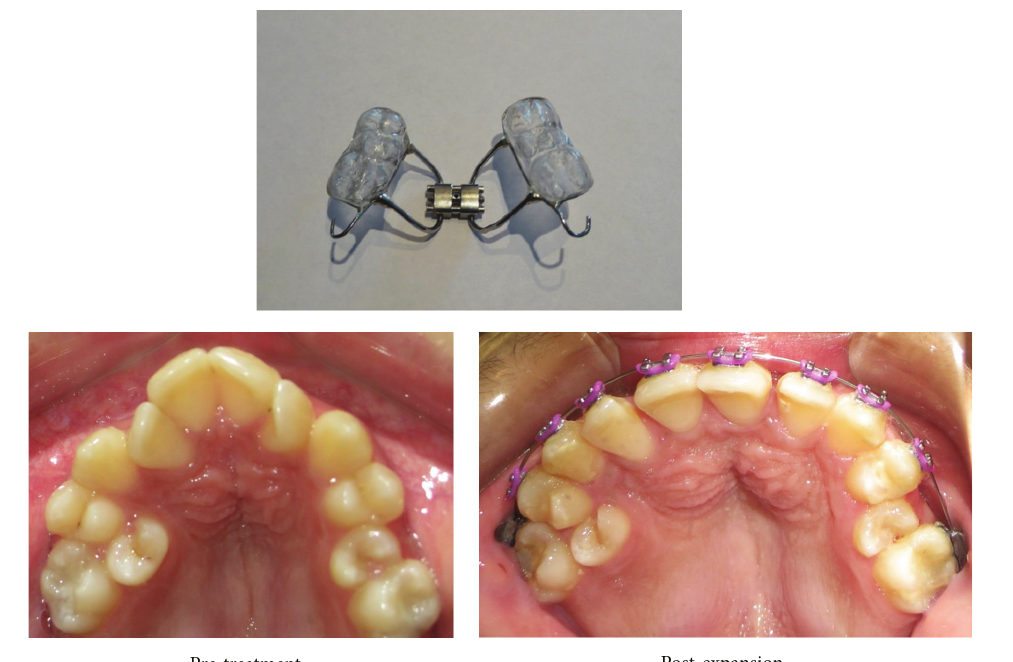
Figure 7: Treatment progress after maxillary orthopedic